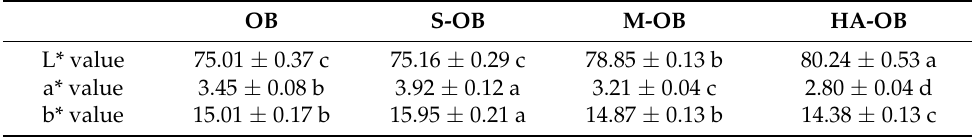
Table 1. Color analysis of the different treated oat bran.